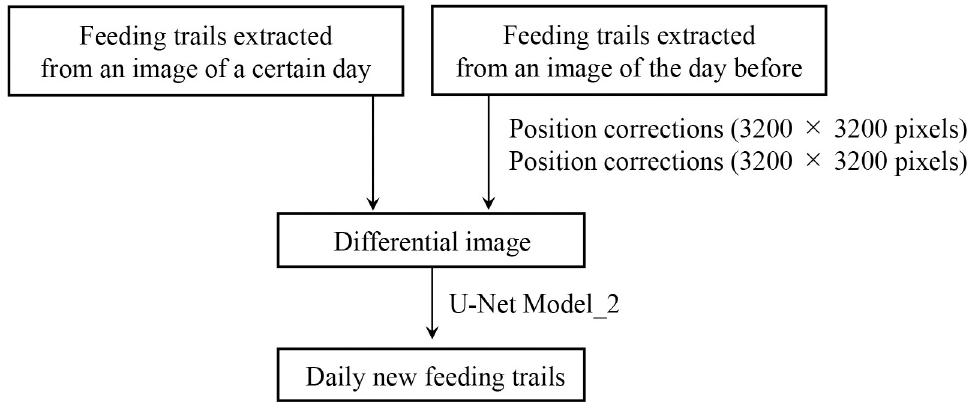
Fig 8. Flowchart of the proposed method for the extraction of the daily new feeding trails.